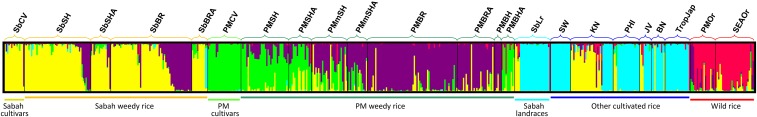
STRUCTURE output at K = 5. Abbreviations used: SbCV, Sabah cultivated rice; PMCV, Peninsular Malaysia cultivated rice; SbSH, Sabah weedy rice with strawhulls and no awns; PMSH, Peninsular Malaysia weedy rice with strawhulls and no awns; PMmSH, Peninsular weedy rice with intermediate strawhulls and no awns; SbSHA, Sabah weedy rice with strawhulls and awns; PMSHA, Peninsular Malaysia weedy rice with strawhulls and awns; PMmSHA, Peninsular Malaysia weedy rice with intermediate strawhulls and awns; SbBR, Sabah weedy rice with brownhulls and no awns; PMBR, Peninsular Malaysia weedy rice with browhulls and no awns; SbBRA, Sabah weedy rice with browhulls and awns; PMBRA, Peninsular Malaysia weedy rice with browhulls and awns; PMBH, Peninsular Malaysia weedy rice with blackhulls and no awns; PMBHA, Peninsular Malaysia weedy rice with blackhulls and awns; PMOr, Peninsular Malaysian Oryza rufipogon; PMLr, Malaysian landraces; TropJap, tropical japonica; SEAOr, O. rufipogon accessions representing other Southeast Asian countries (Thailand, Cambodia and Myanmar).